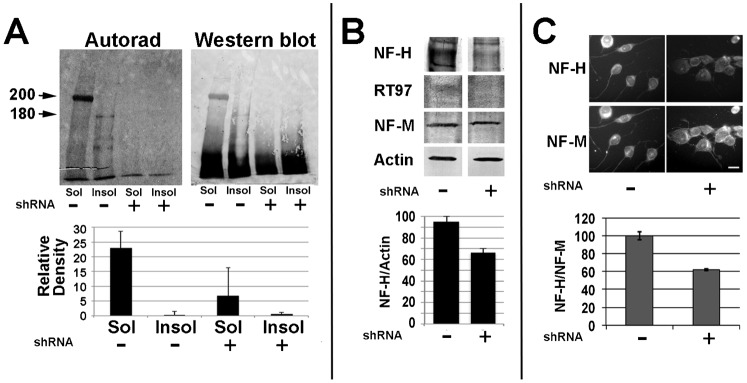
Reduction of NF-H synthesis and steady-state levels by shRNA treatment.(A) Autoradiographic and corresponding immunoblot analyses of material immunoprecipitated from Triton-soluble (“Sol”) and Triton-insoluble (“Insol”) fractions of undifferentiated cells incubated for 2 hr with 35S-methionine 48 hr after transfection with a cocktail of CDS1-4. The accompanying graph presents densitometric analyses of the mean (± standard error) of 200 kDa+180 kDa material in duplicate autoradiographs. NF-H synthesis and steady-state levels were significantly reduced by treatment with CDS1-4 (p<0.001 and p<0.01 for synthesis and steady-state levels, respectively; ANOVA). Additional cells transfected with CDS1-4 48 hr prior to dbcAMP-mediated differentiation were subjected to immunoblot analysis with multiple antibodies (B) or double-label immunofluorescent analyses with anti-H and anti-M (C) as indicated. The accompanying graphs present the ratio of total NF-H/actin (B) and relative intensity ratio of NF-H/NF-M as indicated (C); steady-state levels of NF-H were significantly reduced by shRNA treatment as evidenced by both immunoblot and immunofluorescent analyses (p<0.01 for both; Student's t test; panels B and C, respectively). Bar: 25 µm.